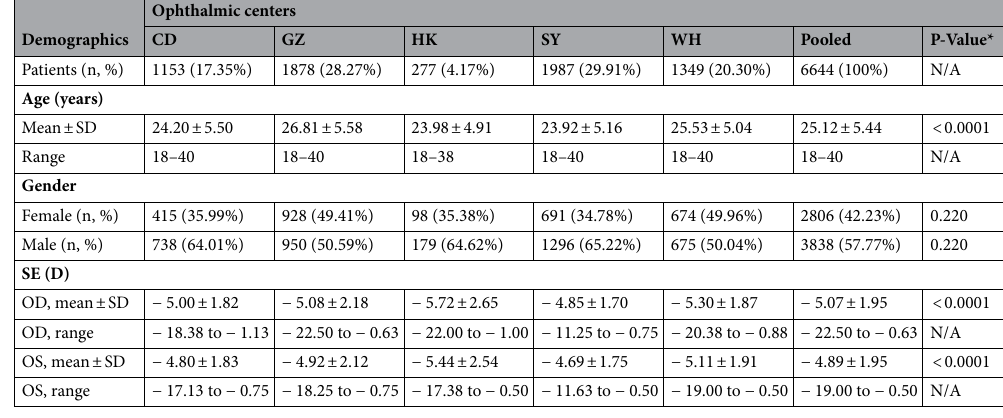
Table 1. Demographic data of patients by different ophthalmic centers. SD standard deviation; SE spherical equivalent; D diopter; GZ Guangzhou Aier Eye Hospital; SY Shenyang Aier Eye Hospital; CD Chengdu